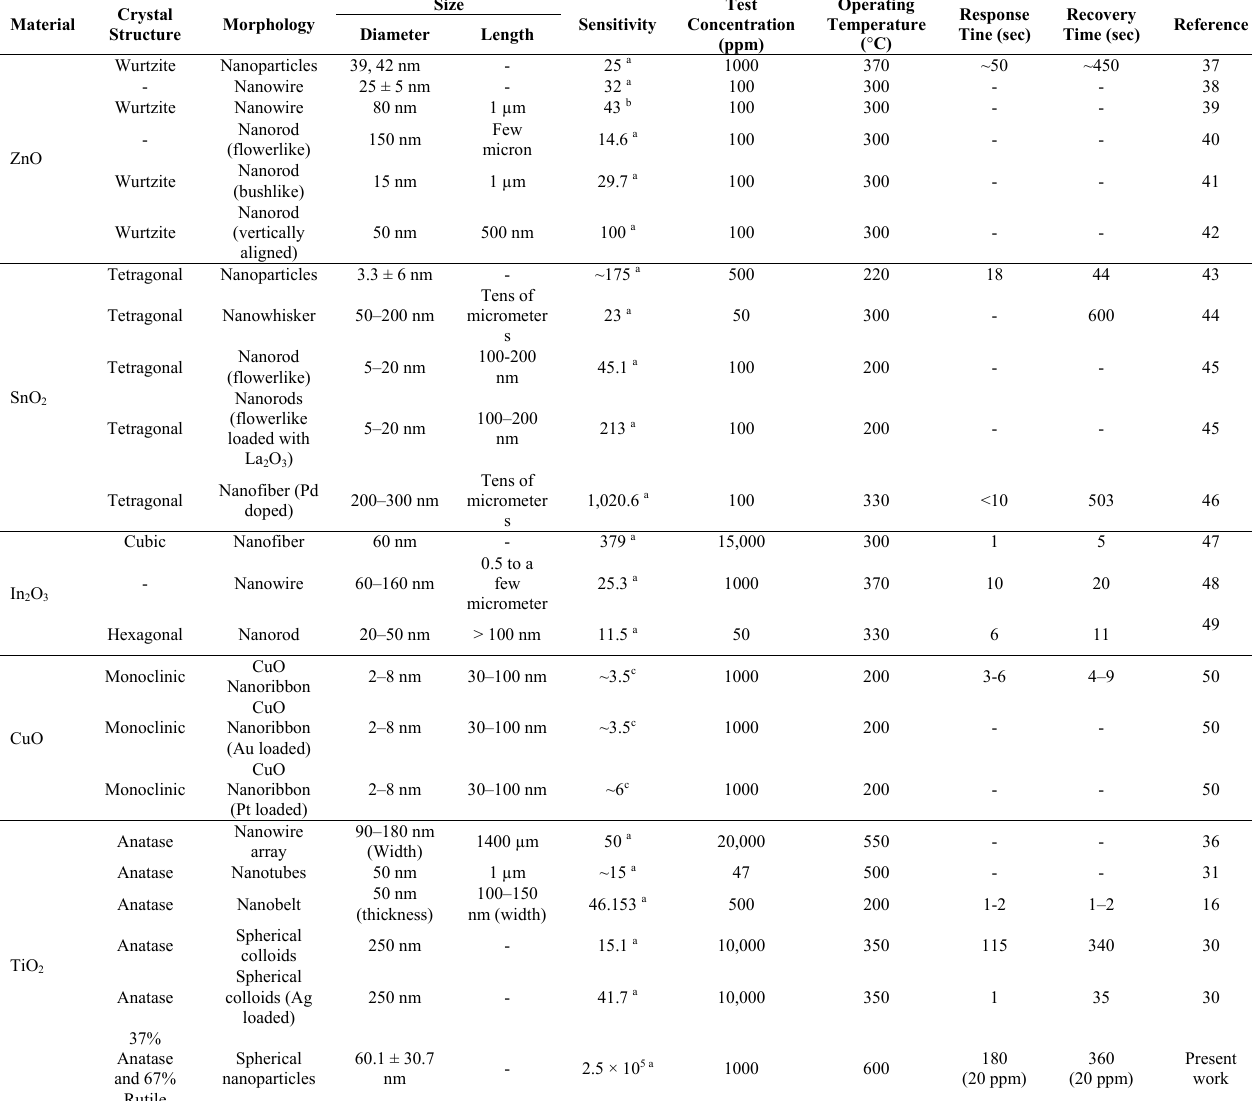
H OH gas by using different metal 2 5